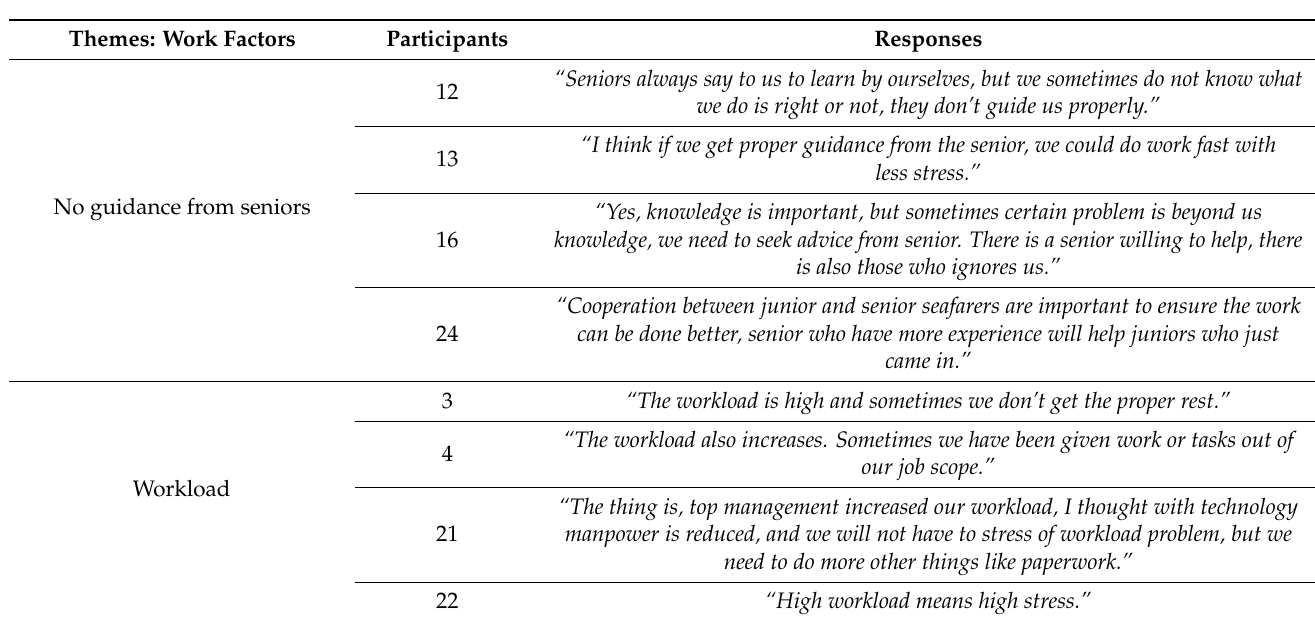
Table 8. Theme of work